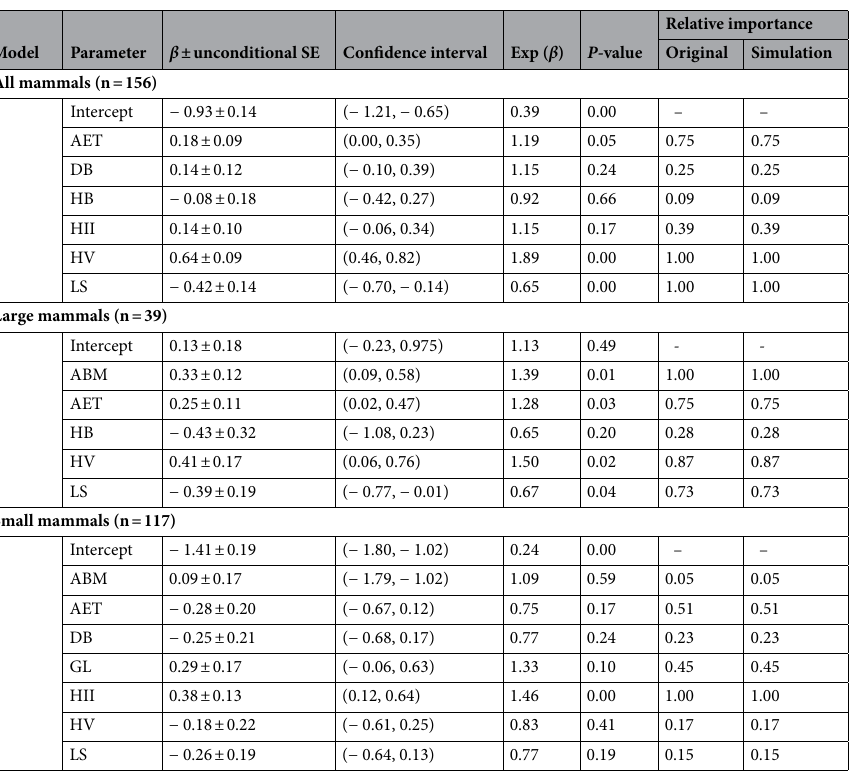
Table 2. Model averaging results for the best candidate models from QAICc-based (Quasi Akaike Information Criterion Corrected for small sample size) model selection (delta < 2) for large, small and all (pooled data) mammal species in Iran. Relative importance values represent the comparison of the contribution of each covariate in the original models and the simulated models. β is the estimated beta coefficient. Variable codes explained in Table